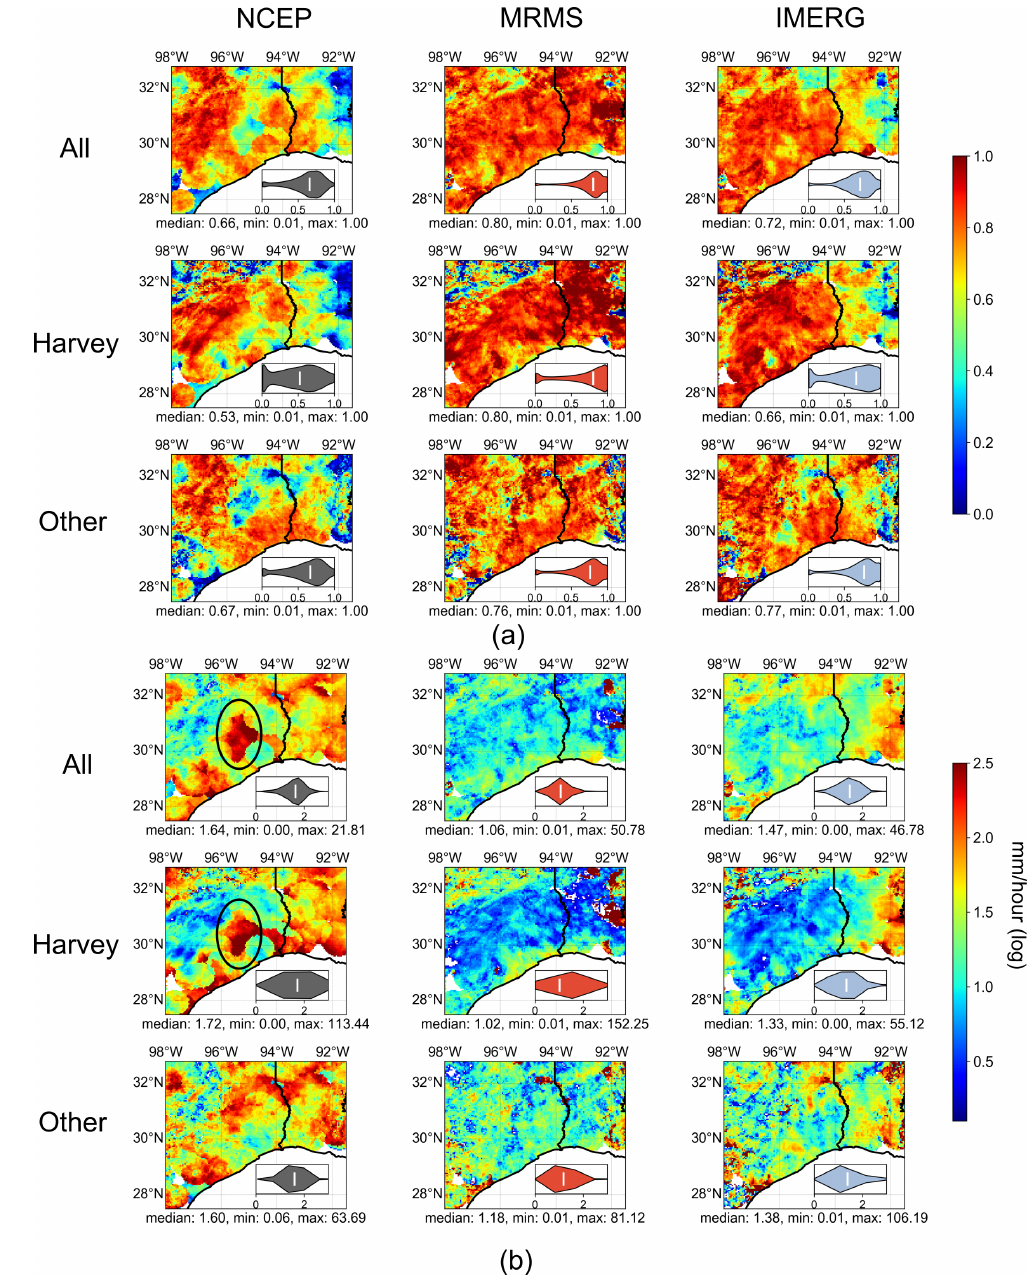
Figure 3. Spatial plot of Multiplicative Triple Collection (MTC) results ( a ) Correlation Coefficient (CC); ( b ) Root Mean Squared Error (RMSE) for three cases (concatenated all events, Harvey-only and non-Harvey) in each row, and each column represents each product. The small panel inside each axis is the violin plot for the metric, and the white bar is where the median value is located. Two marked circles emphasize where the National Centers for Environmental Prediction (NCEP) is highly